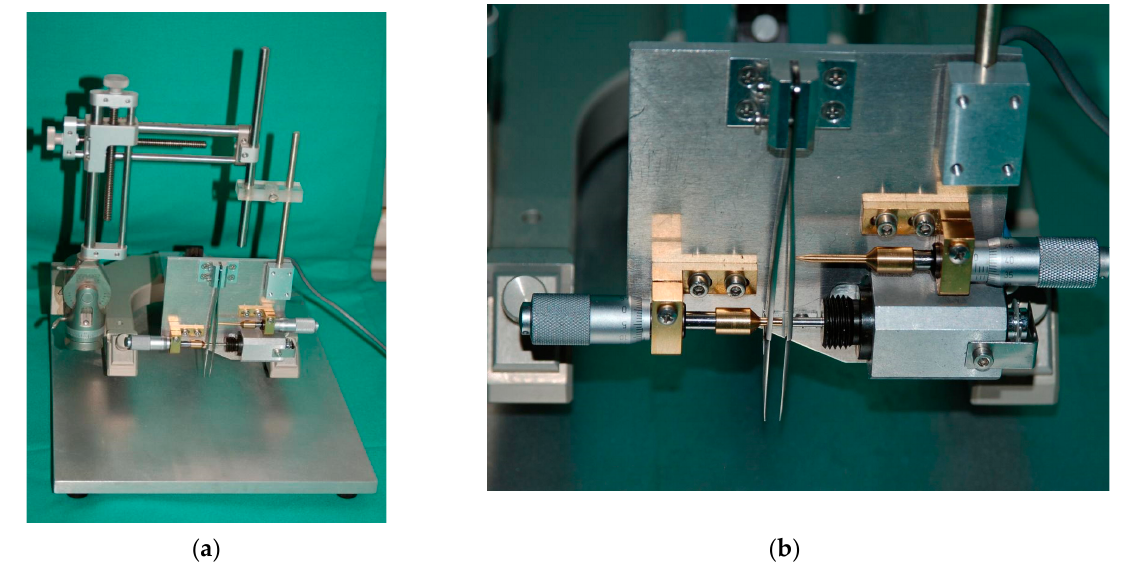
Figure 2. ( a ) The custom-made spinal-cord-compression device (Curtis et al.,1993) [26] was attached to a stereotaxic frame and mounted on a metal block; ( b ) controlled by an electromagnetic drive and timed current, the drive pin closes the forceps by pressing the moving blade. The degree of closure of the forceps can be adjusted by the limiting pin, which passes through a drilled hole in the stationary blade. The closing pin is used to advance the moving blade and thus position the tips of the forceps accurately next to the spinal cord. The use of calibrating screws allows vernier adjustment and, thus, the measurement and standardization of the SCI (Apostolova et al., 2006; Manthou et al., 2015; Semler et al., 2011) [25,27,28].